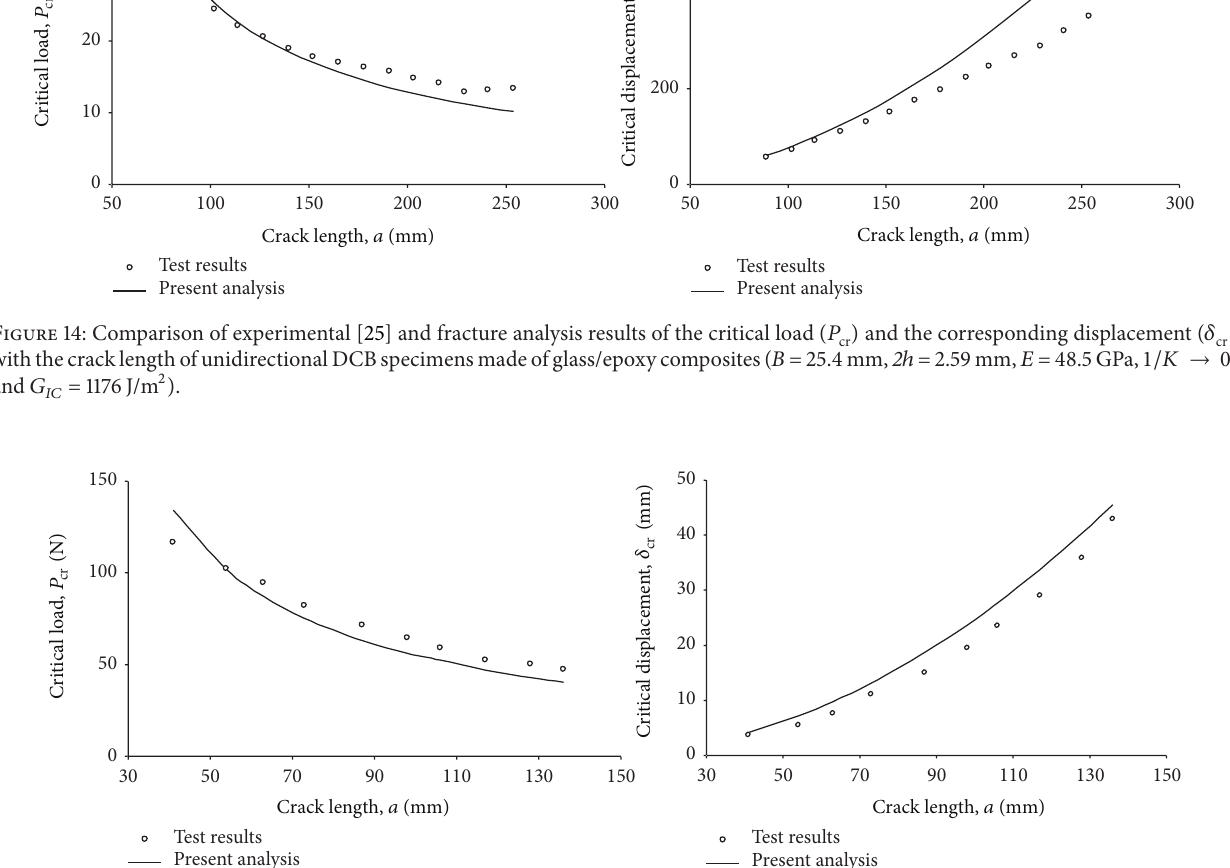
Figure 15: Comparison of experimental [26] and fracture analysis results of the critical load (𝑃 with the crack length of unidirectional DCB specimens made of glass/polyester composites ( 𝐵 = 20mm, 2 ℎ = 6mm, 𝐸 = 33 GPa, 1/𝐾 → 0 , and 𝐺 𝐼𝐶 = 1018 J/m 2 ).